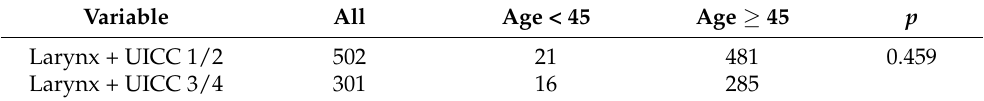
Table 3. Larynx tumors in combination with categorized UICC stages in comparison to age groups.